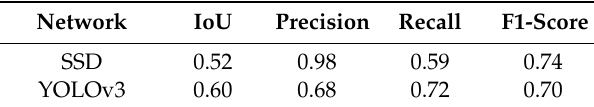
Table 4. Average Intersection over Union (IoU), Precision, Recall and F1-score values for SSD and YOLOv3 networks.